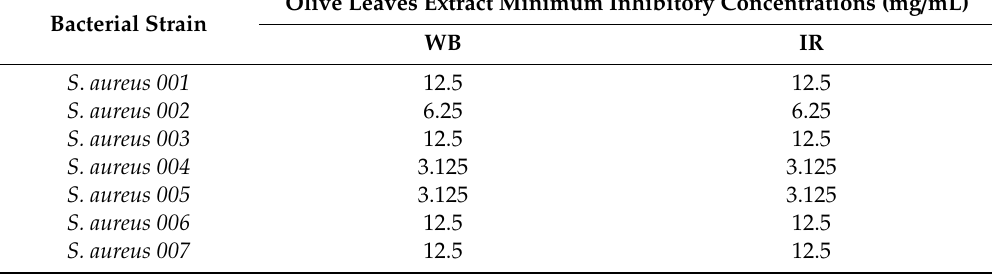
Table 1. Minimum Inhibitory Concentrations (MICs) of WB and IR olive leaves extract against twenty Staphylococcus aureus